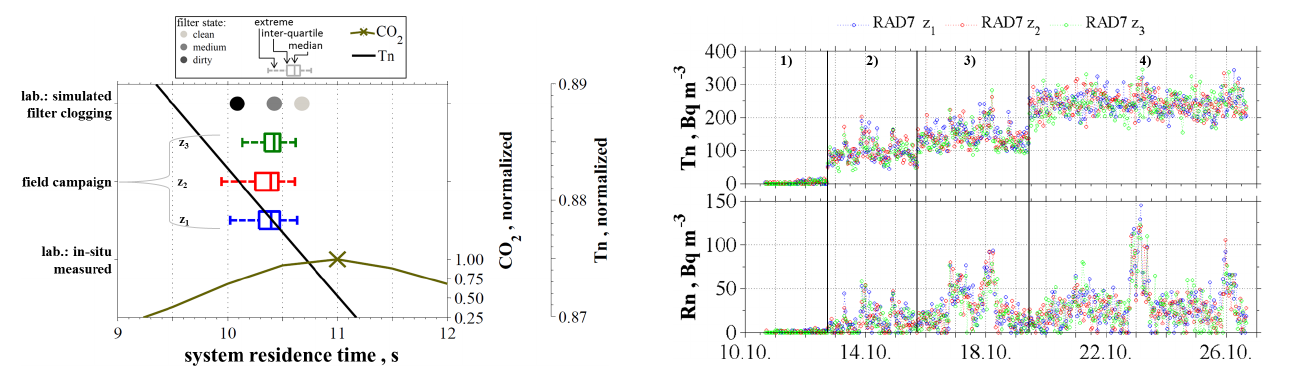
Fig. 5. Comparison of (i) calculated residence times from the simu- lated filter clogging experiment in the laboratory (filled circles), (ii) residence times determined from the field data set ( z 1 – z 3 with me- dian, interquartile range and extreme values) and (iii) in situ mea- sured residence times (CO 2 experiment, green line) with (iv) the resulting radioactive Tn decay (black line) calculated from Eq. (1).